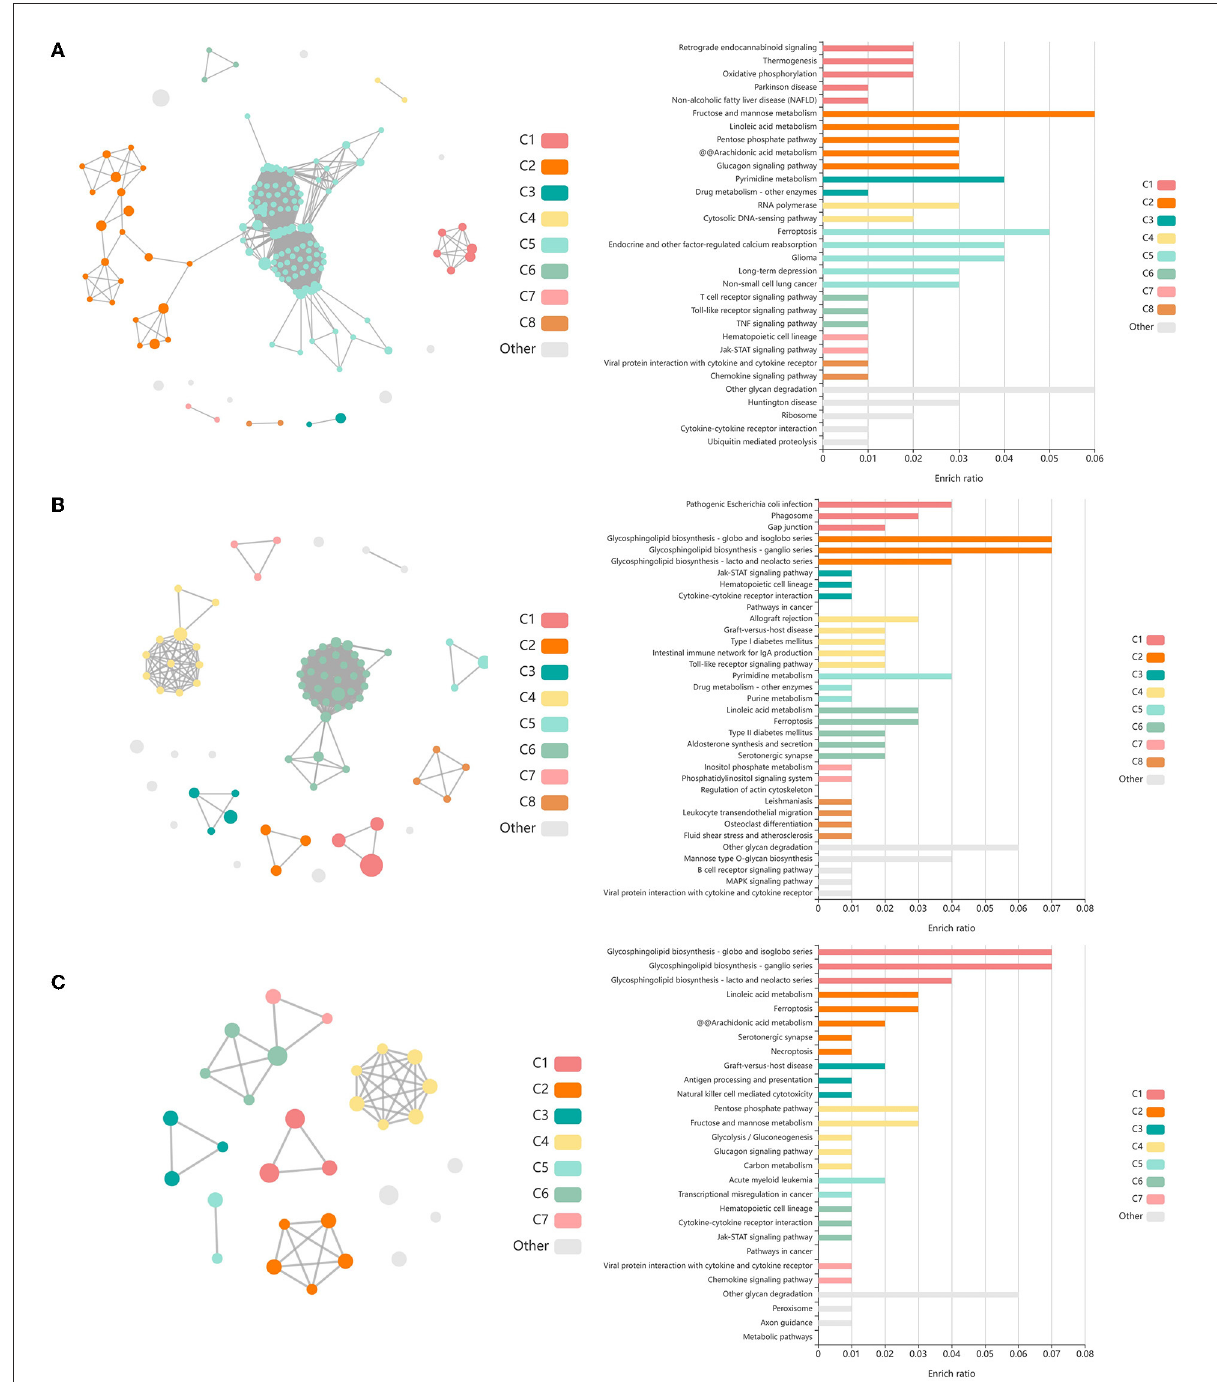
FIGURE4 Clustering of enriched KEGG pathways by term identity from KOBAS-i analysis of DEGs influenced by time in both vaccination groups. Each node represents an enriched term, with color corresponding to the unique cluster based on term identity. Each edge (line between nodes) represents a significant correlation between pathway terms. Bar graphs represent the pathway terms found within each pathway (by color) and the level of enrichment (Enrich ratio). Gray nodes and bargraphed terms represent enriched pathways which did not associate within the clustering model. (A) KEGG pathways derived from T1 vs. T3 analysis clustered into eight unique clusters. (B) KEGG pathways derived from T1 vs. T4 analysis clustered into eight unique clusters. (C) KEGG pathways derived from T2 vs. T4 analysis clustered into seven unique